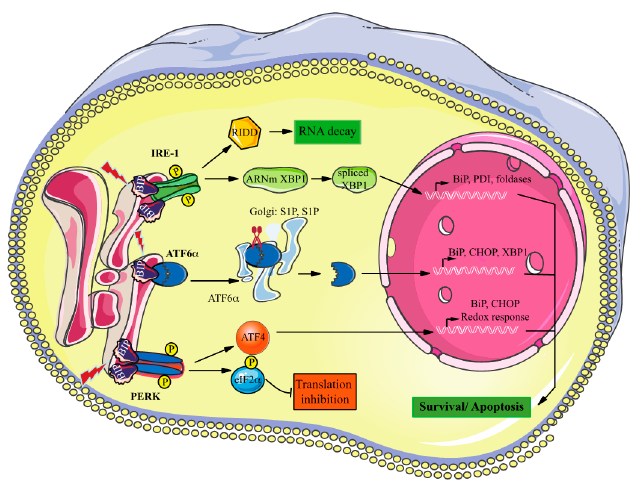
Figure 2. Schematic of pathways involved in the UPR.